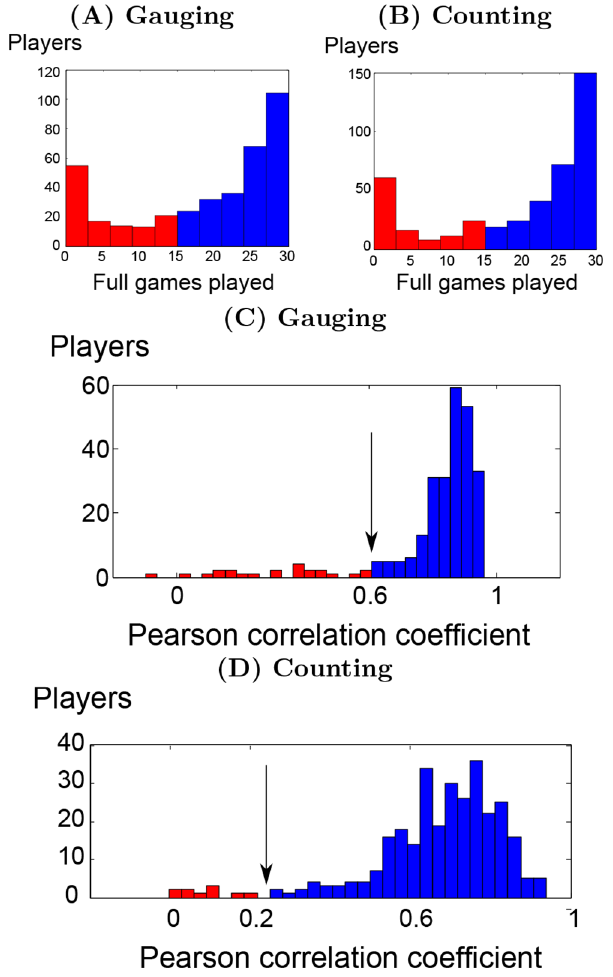
Fig 7. Filters for participants ’ trustworthiness. (A),(C) gauging game , (B),(D) counting game . (A,B): Histograms of the number of full games played by participants. (C,D): Histograms of the correlations between judgments and true values for each participant. Rejected participants are displayed in red while kept participants are in blue, to the right of the black